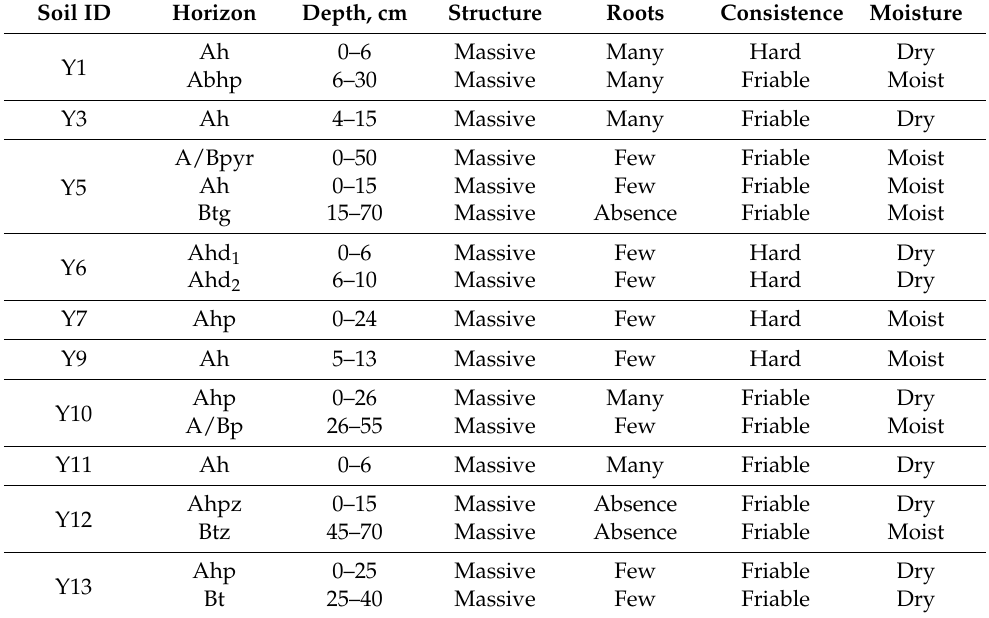
Table 2. Description of the soil monoliths used for thin